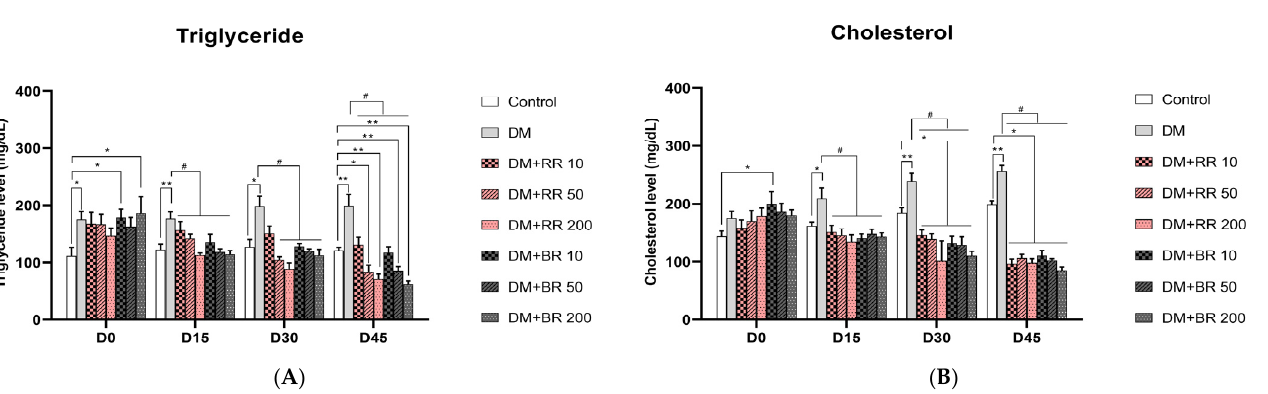
Figure 2 . Effects of various doses of RR and BR on triglyceride ( A ) and cholesterol Figure 2. Effects of various doses of RR and BR on triglyceride ( A ) and cholesterol ( B ) levels in ( B ) levels in STZ - induced diabetic rats . * P < 0 . 05 and ** P < 0 . 01, diabetic control group vs . STZ-induced diabetic rats. * p < 0.05 and ** p < 0.01, diabetic control group vs. healthy control group; healthy control group; # P < 0 . 05, treated group vs . diabetic control . Values represent mean # p < 0.05, treated group vs. diabetic control. Values represent mean ± S.E.M. (n = 8). ± S . E . M . (n = 8) .